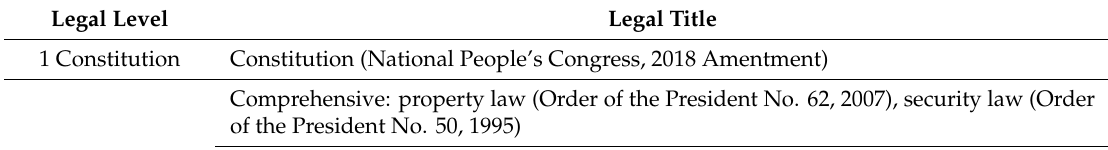
Table A1. Legal system of natural resource administration in